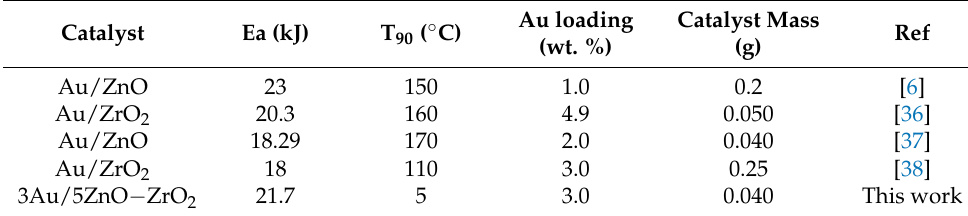
Table 4. Comparison of CO oxidation